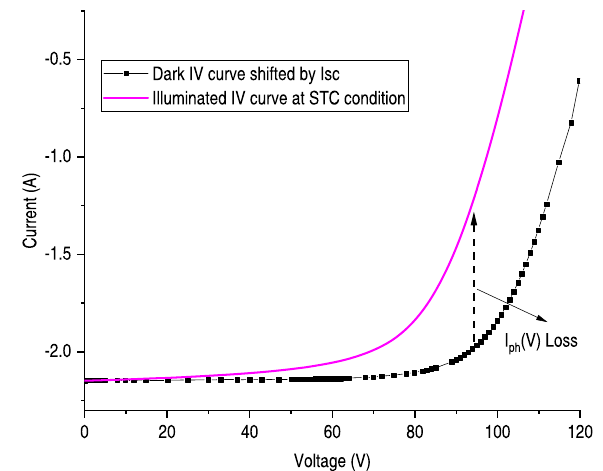
Fig. 1 Dark and illuminated IV superposition failure in a CIGS module. The illuminated IV (magenta) is measured at one sun and 25 °C. The dark IV (black) is measured at 25 °C and shifted by the I SC value at one